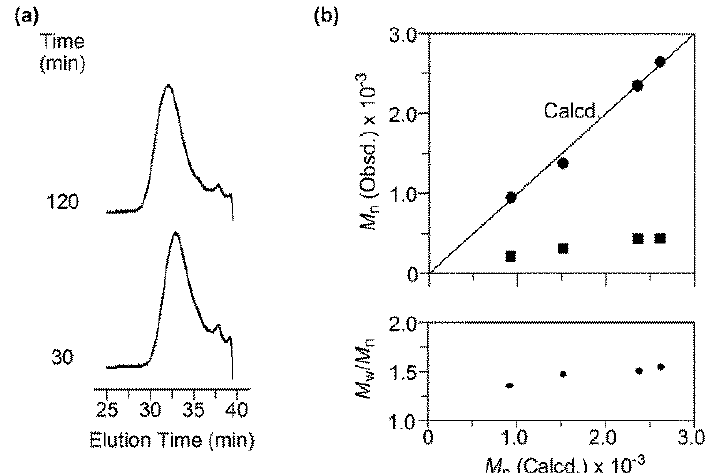
Figure 3. ( a ) SEC curves of poly(MalVE- co -EtMI) using 0.2 mol·L − 1 NaNO 3 aq. as the eluent; and ( b ) experimentally observed M n and M w / M n value of poly(MalVE- co -EtMI) plotted against theoretical M n of poly(MalVE- co -EtMI). Filled circles and squares correspond to the M n data obtained by 1 H NMR and SEC, respectively.